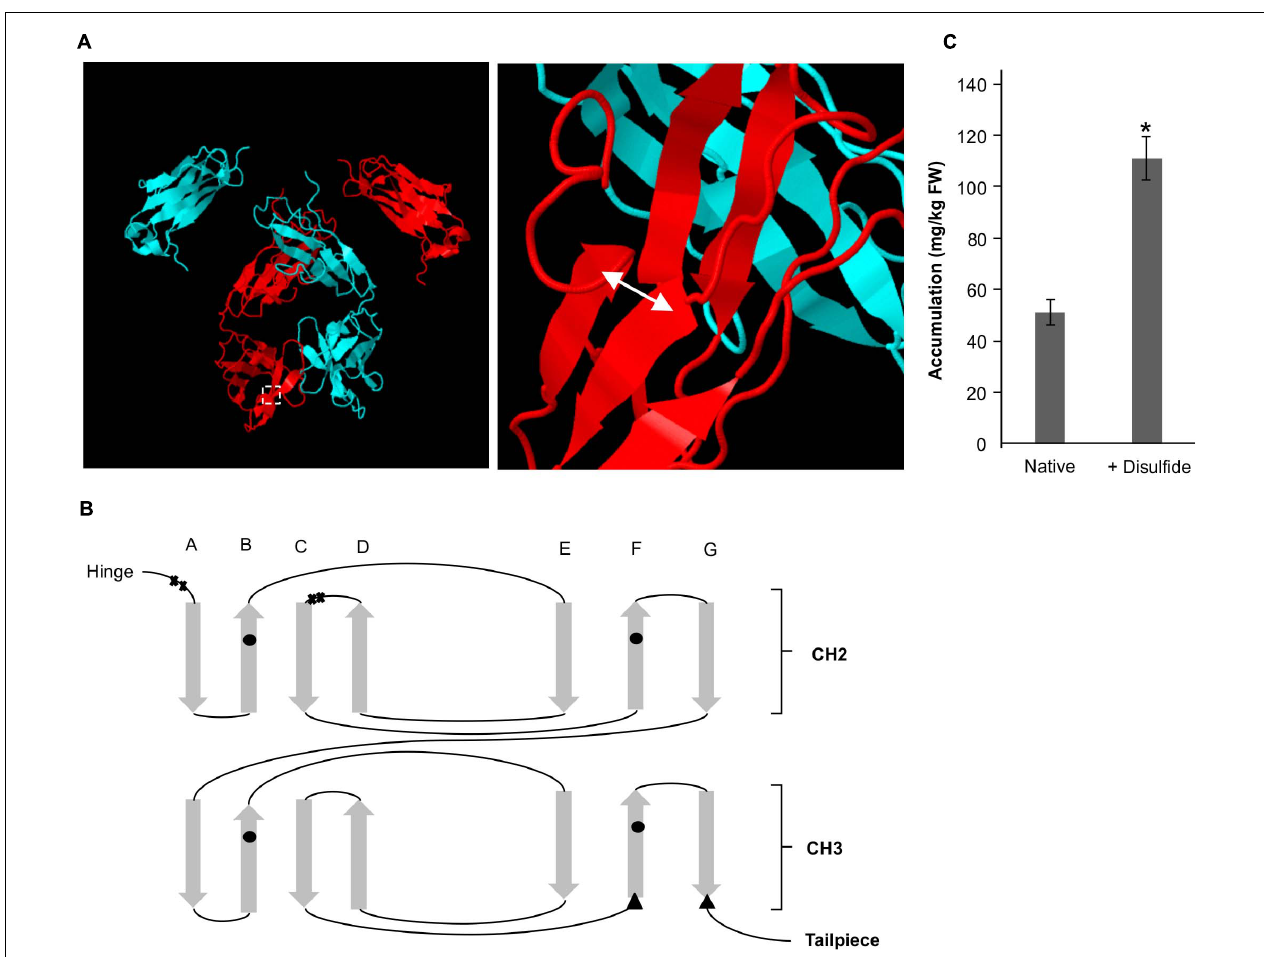
FIGURE 4 | A de novo disulfide bond enhances accumulation for a Sec-targeted V H H-Fc. (A) Structural model showing the backbone of two dimerized Fc chains (blue and red). The double headed arrow indicates the position of the introduced disulfide. (B) Greek key connectivity schematic showing the relative positions of native disulfides and the introduced disulfide in the Fc. X indicates cysteines involved in interchain disulfide formation, circles indicate cysteines involved in intrachain disulfide formation and triangles indicate introduced cysteines for de novo disulfide formation. (C) Bar chart showing accumulation of Sec-targeted native V H H-Fc and a V H H-Fc with an added disulfide. *indicates statistical significance as determined by a T -test with p < 0.05, n = 3 biological replicates. Error bars shown are standard error of the